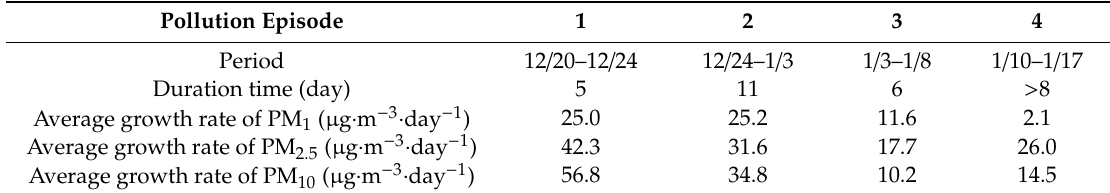
Table 1. Characteristic of the four pollution